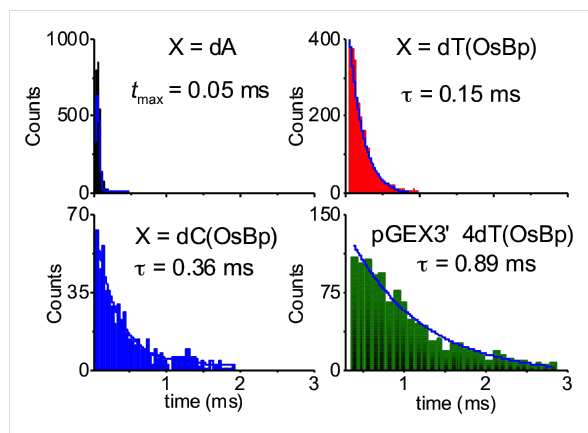
Figure 4: Translocation time histograms for four different oligos: Three are oligodeoxyadenylates, dA 10 XdA 9 where X = dA, dT(OsBp), or dC(OsBp). The fourth is a 23 nt long deoxyoligo pGEX3’ (PCR primer) and contains four modified bases, dT(OsBp). Translocation speed decreases in the presence of a single modified pyrimidine; dC slows down the oligo more compared to dT, and the presence of additional osmylated bases yields further